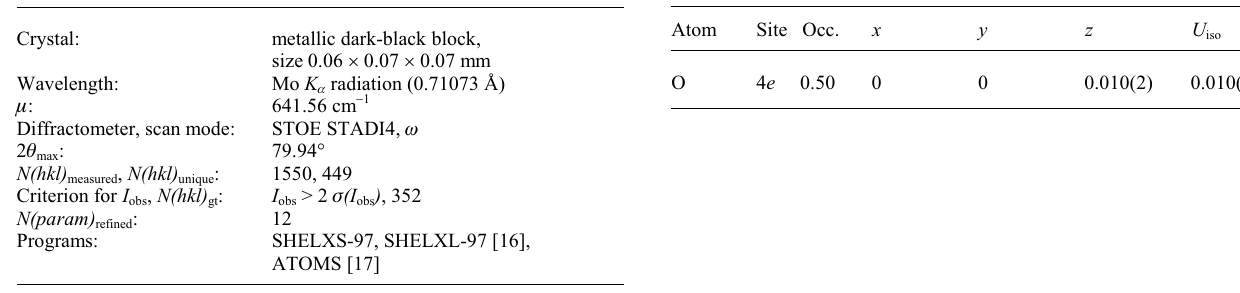
Table 3. Atomic coordinates and displacement parameters (in Å 2 ).